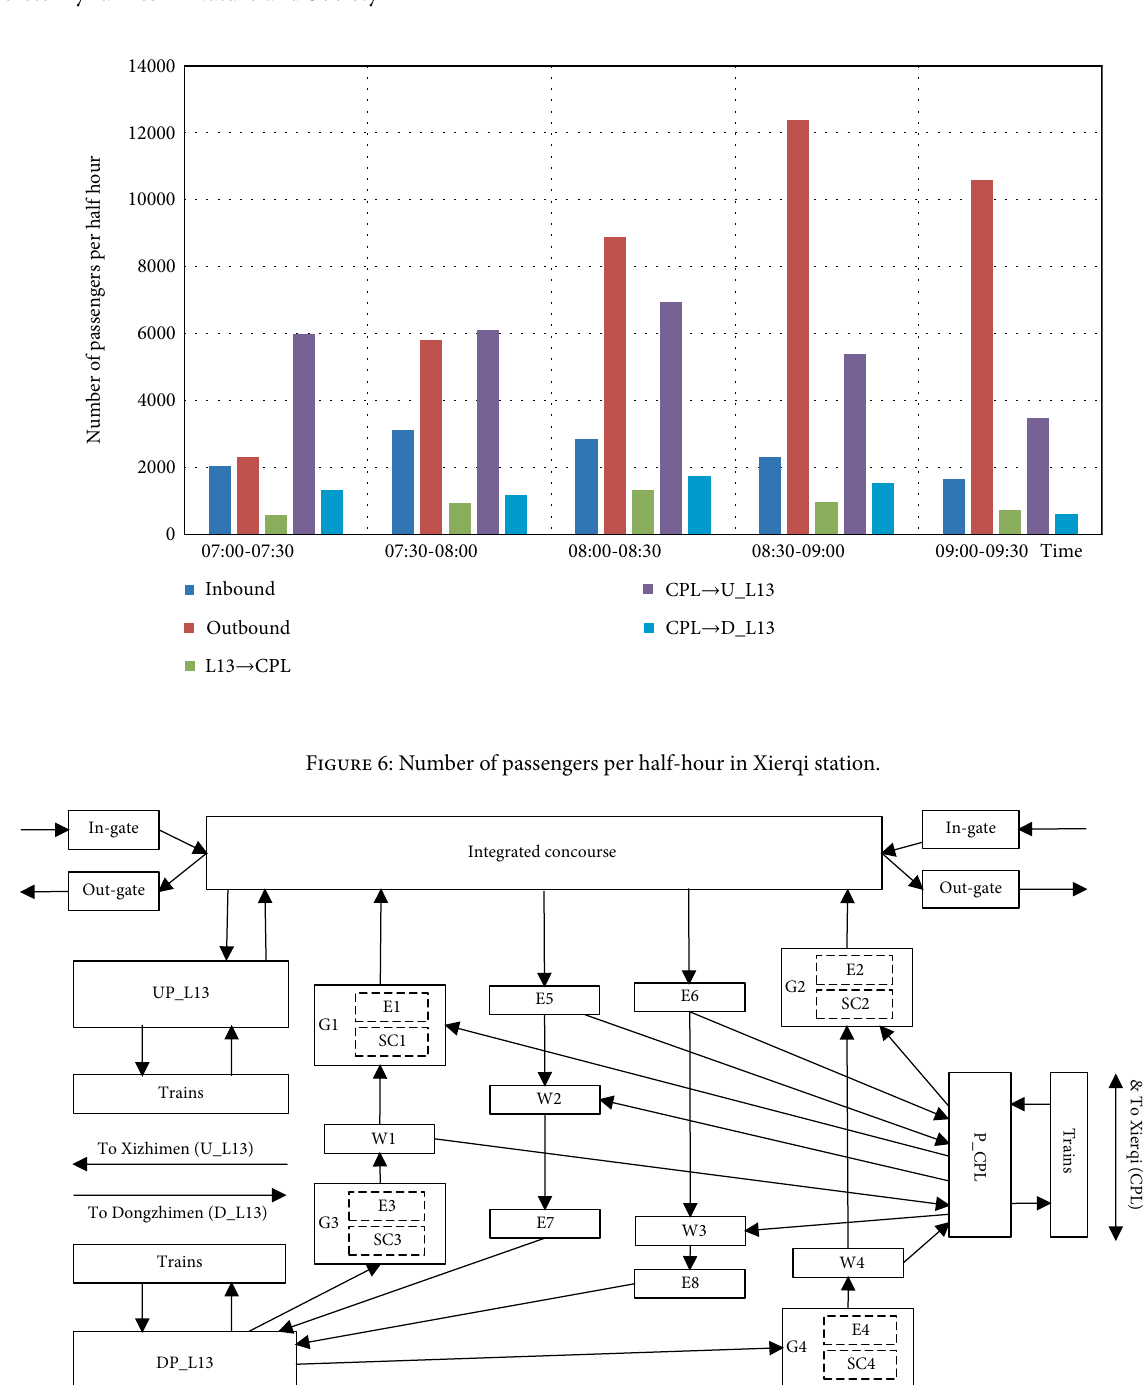
Figure 7: Xierqi station network. Abbreviations of facilities will be applied for convenience: Escalator: E, Staircase: SC, Walkway: W, Line 13: L13, Changping line: CPL. The up and down directions of L13 are called as U_L13 and D_L13 respectively. The separate side platforms for them are referred to as UP_L13 and DP_L13. The platform for CPL is